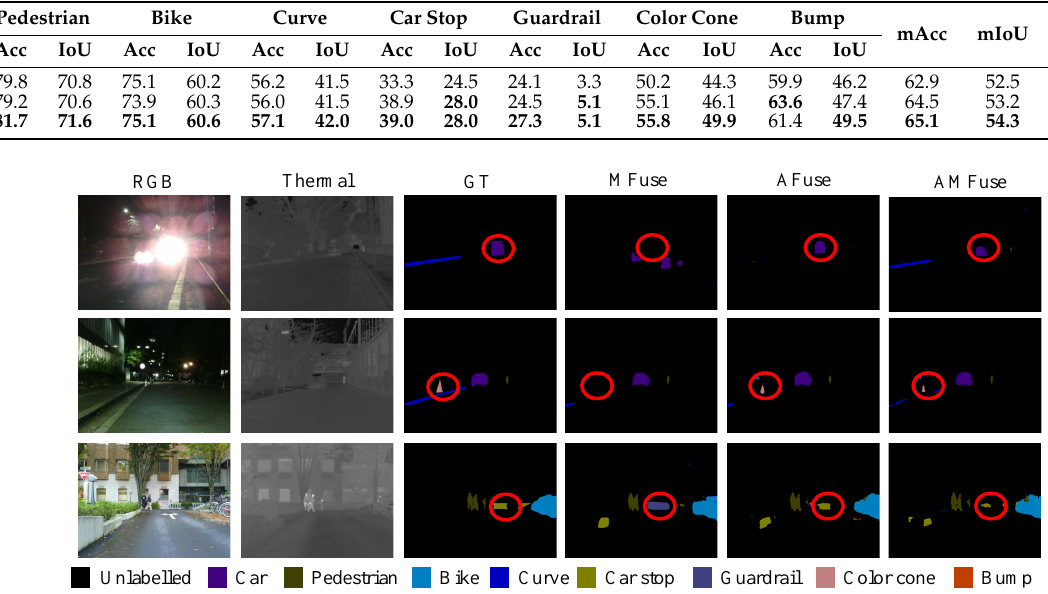
Figure 9. The sample qualitative demonstrations of MFuse, AFuse and AMFuse modules based on ResNet-50